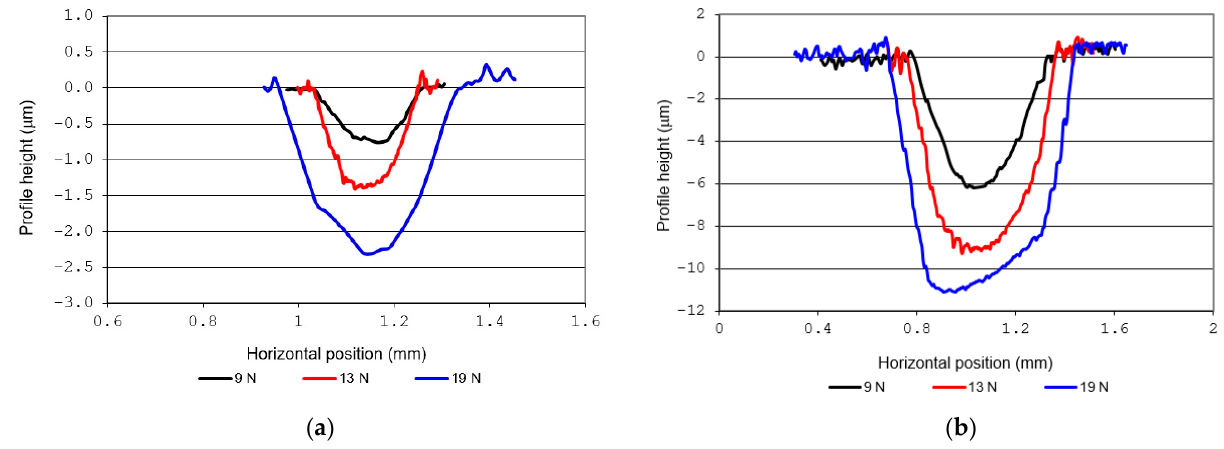
Figure 6. Profile shapes of the wear trace of the investigated coatings after tribocorrosion tests at an open circuit potential, E OCP : ( a ) Cr/CrN PVD, ( b ) gas nitrided with subsequent oxidation and impregnation.